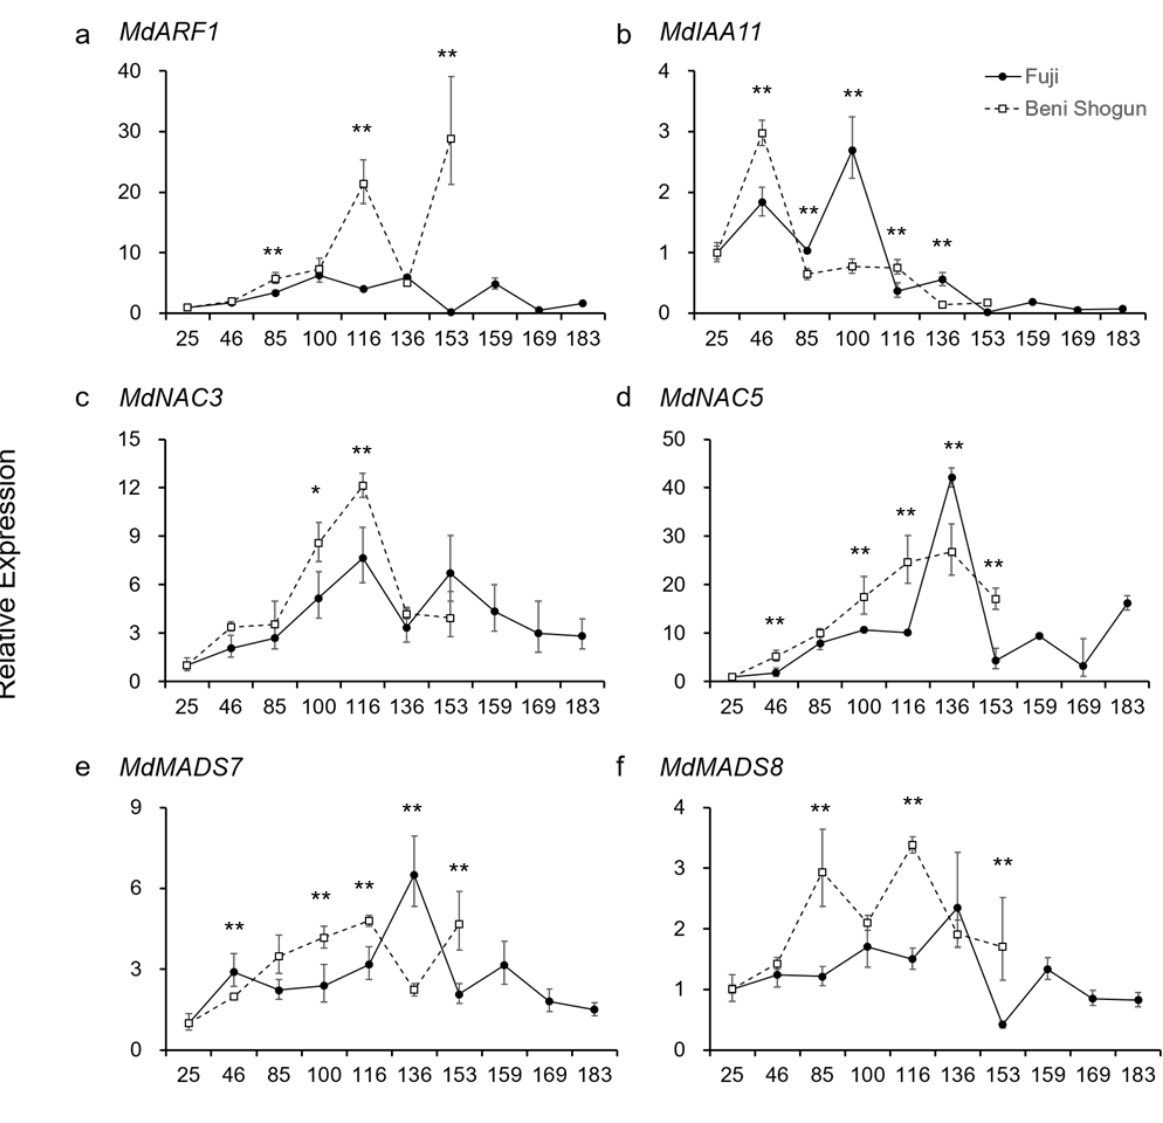
Figure 4. Relative gene expression patterns related to auxin and developmental regulation of ‘Beni Shogun’ and ‘Fuji’. Genes are grouped as auxin signal transduction ( a , b ) and developmental regula- tion ( c – f ) genes. All genes were analyzed by using qRT-PCR and normalized relative to the expression reference gene, ACTIN . Relative expression levels were normalized to 25 DAFB values. Error bars indicate the ± SE ( n = 3). Single stars (*) indicate statistical significance at p < 0.05, while double stars (**) indicate significance at p <